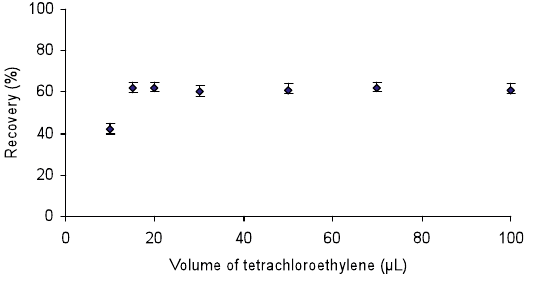
Figure 2. Effect of extraction solvent volume on extraction recovery (analyte concentration 1 mg L -1 , volume of disperser solvent was 1 mL, pH = 3, n =